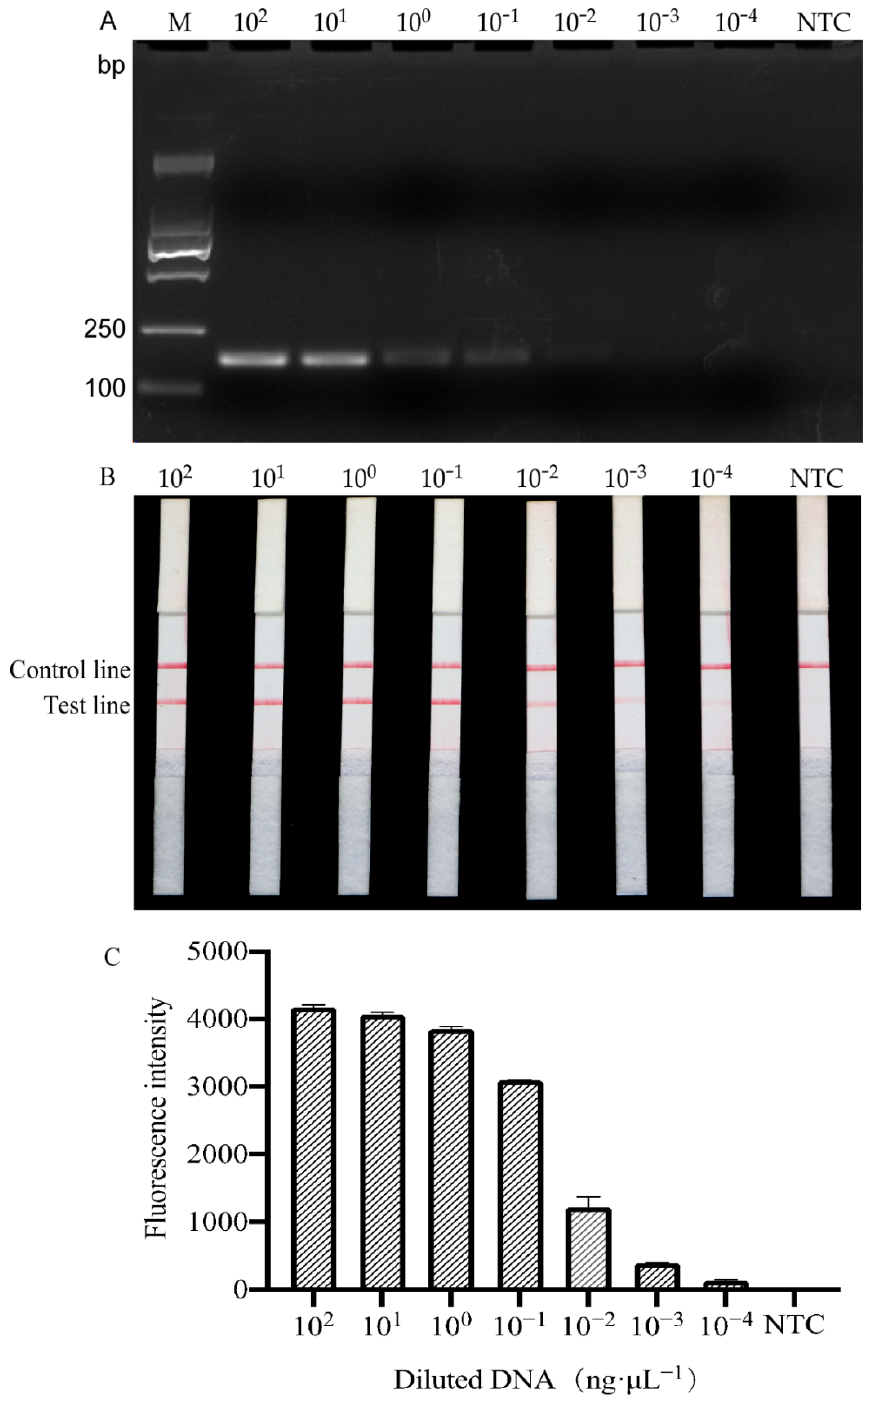
Figure 3. DNA concentration gradient sensitivity test of the RPA system. ( A ) Agarose gel electrophoresis results. ( B ) LFD test strip results. ( C ) Fluorescence was measured using the RPA/Cas12a method. M, D2000 marker; NTC, no template was added as a negative control. The presence of two lines indicates a positive result.